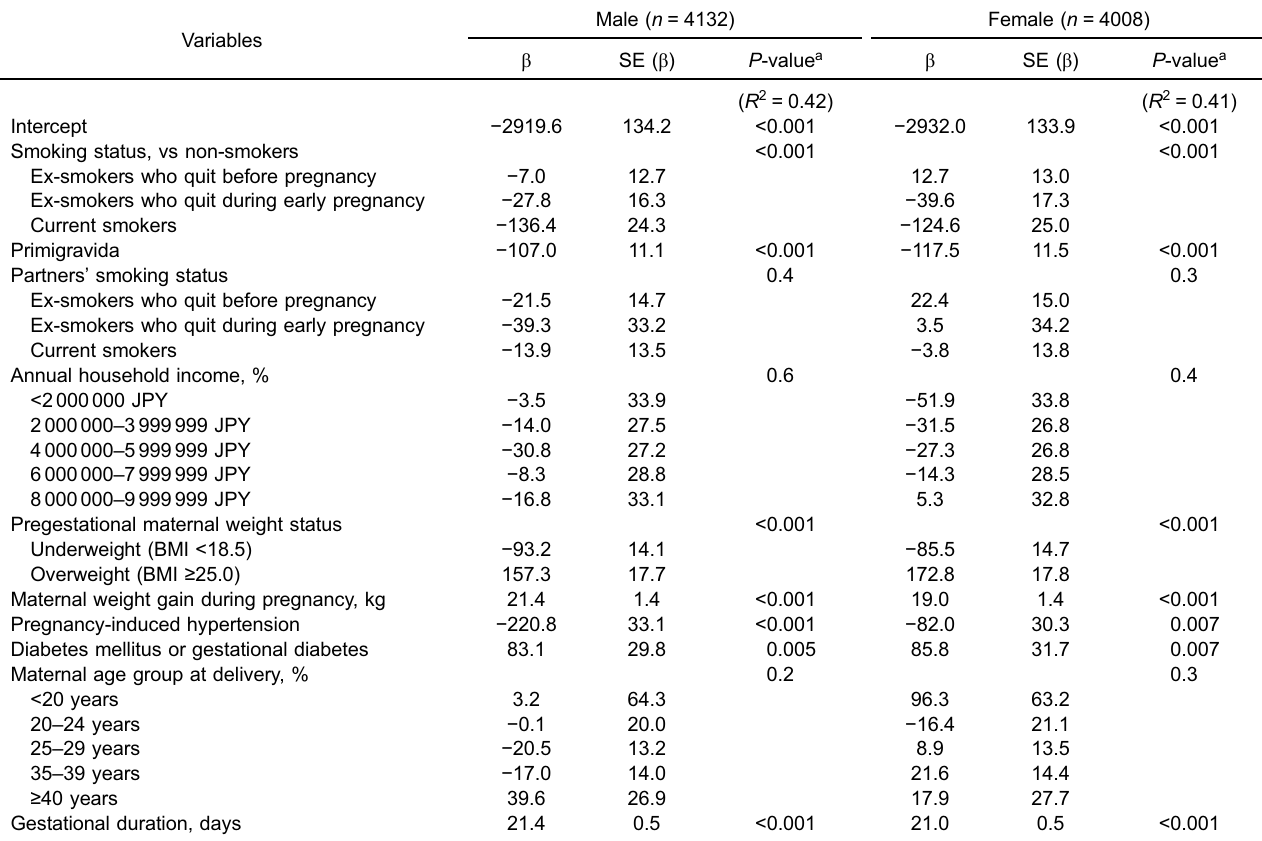
Table 2. Multiple linear regression model for birth weight in male and female infants Male ( n = 4132) Female ( n = 4008) Variables β SE ( β ) P -value a